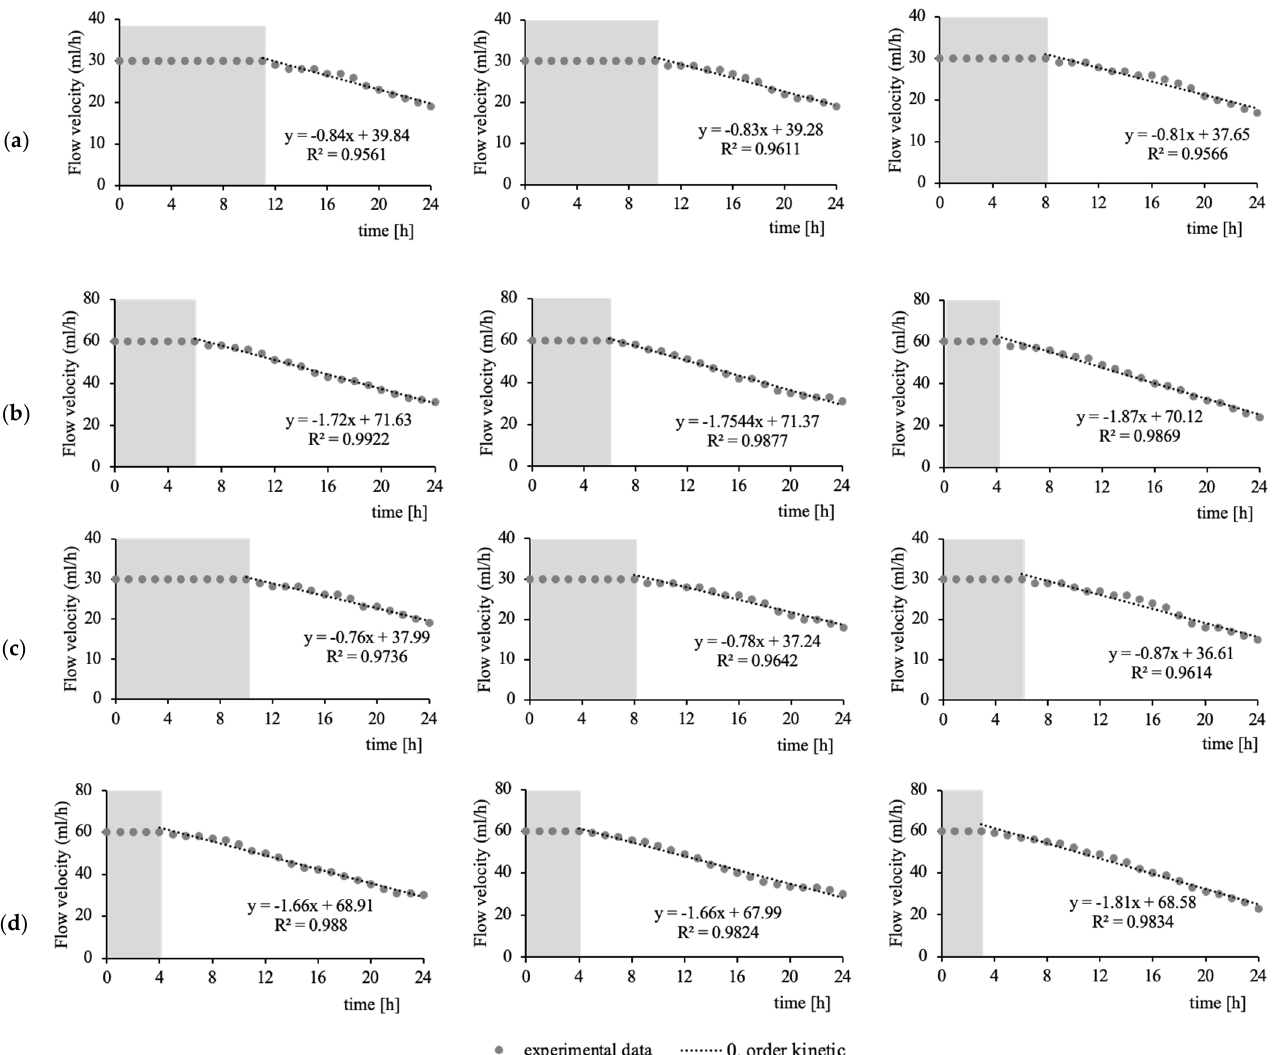
Figure 3. Flow velocity in the column experiment for S1: at ( a ) 0.5 mL/min and ( b ) 1.0 mL/min and for S2: at ( c ) 0.5 mL/min and ( d ) 1.0 mL/min (left—DOM; middle—HLS; right—SHS).